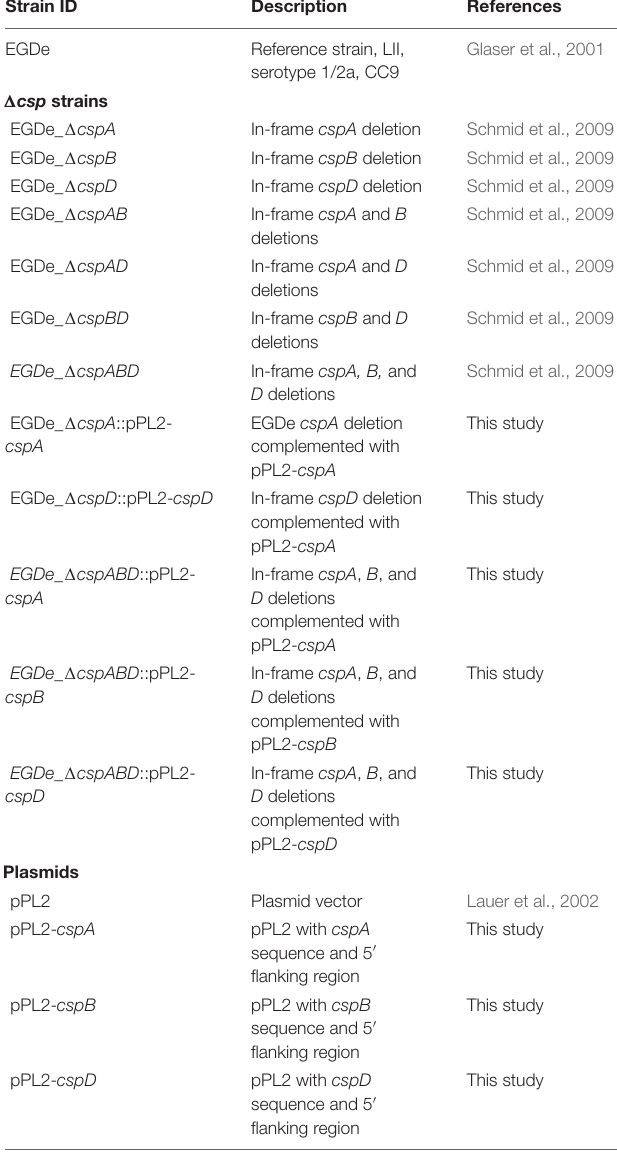
TABLE 1 | Strains used in this